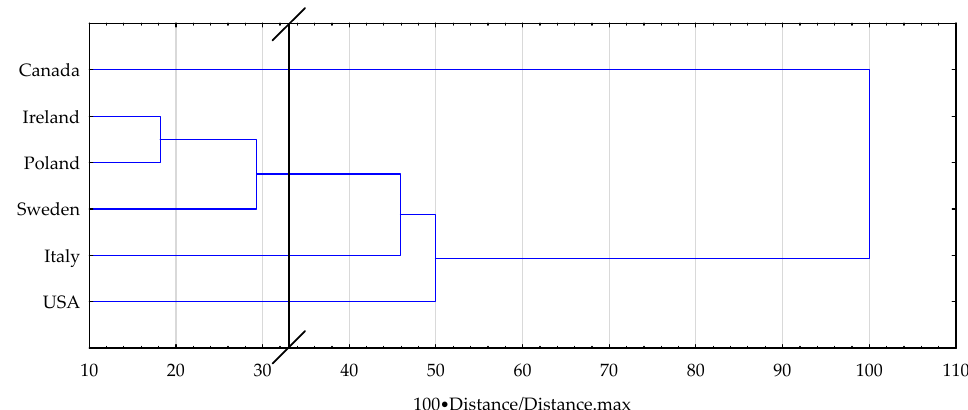
Figure 8. Cluster analysis of economic indicators in the papers selected for analysis.